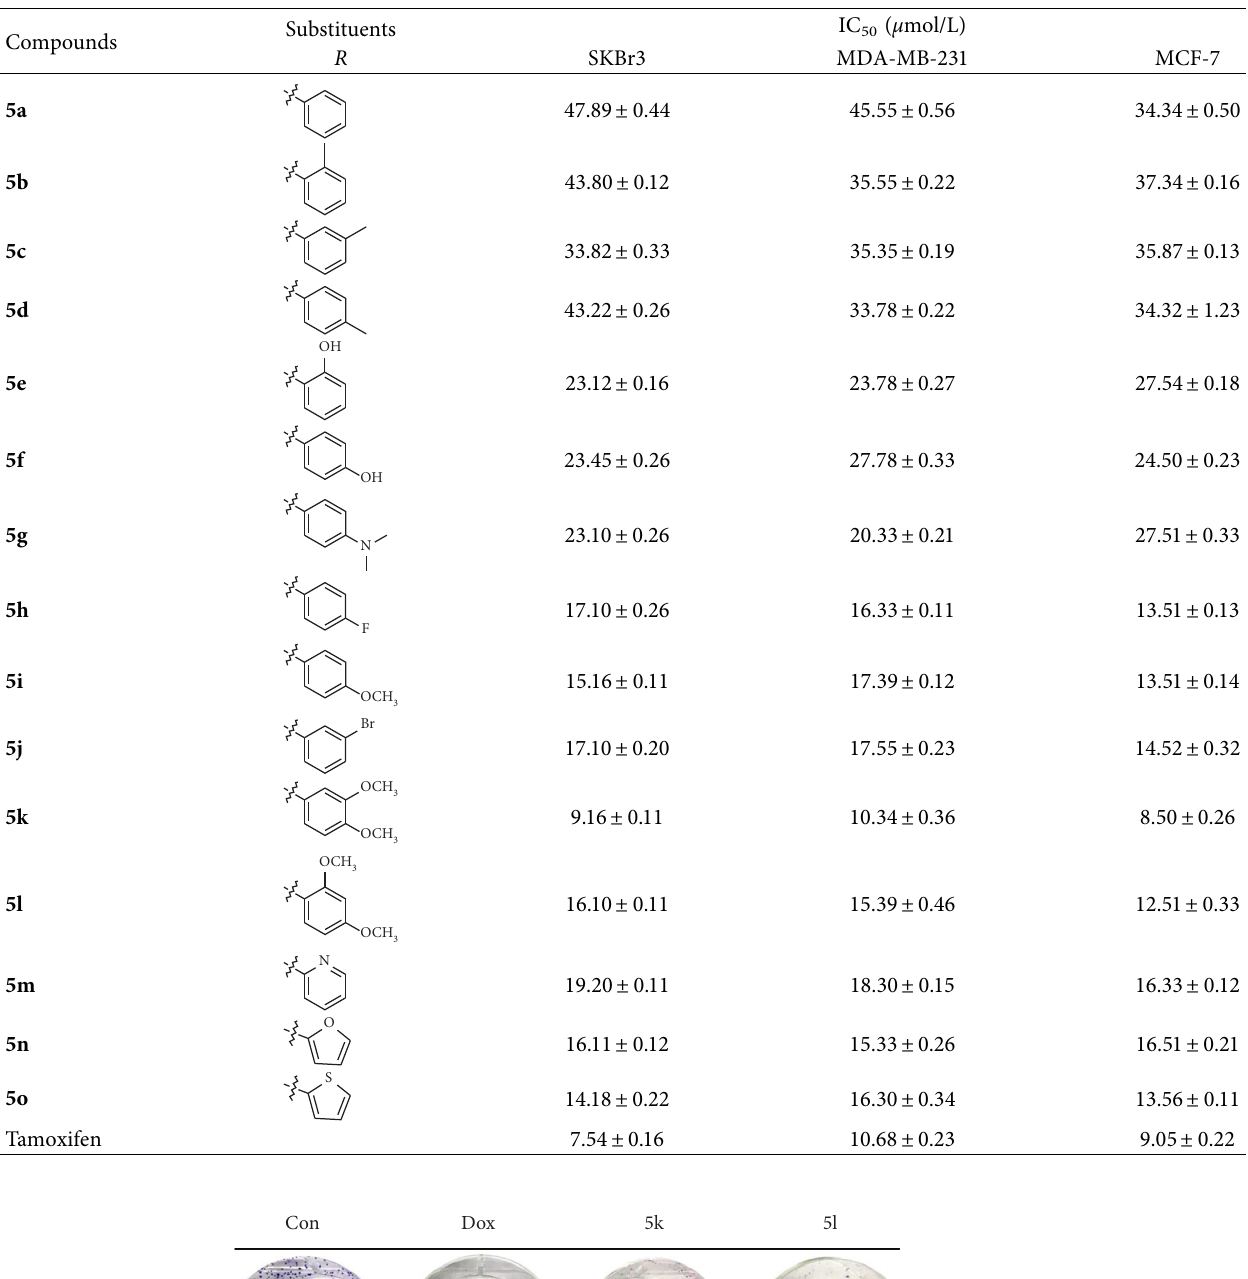
Table 1: The cytotoxicity of target compounds 5a–5o against SKBr3, MDA-MB-231, and MCF-7 cancer cell lines. Compounds